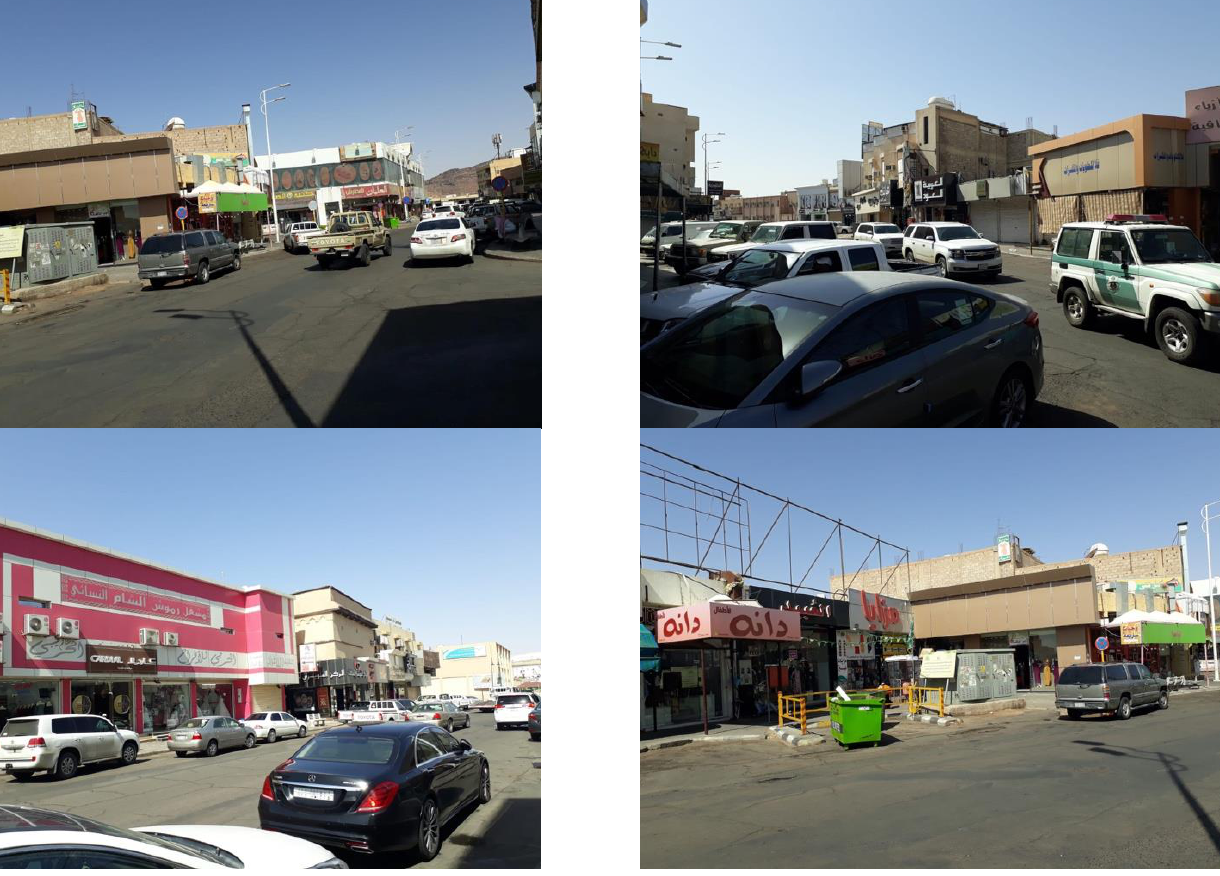
Figure 6. Barzan marketplace main street before development. Source: Authors.